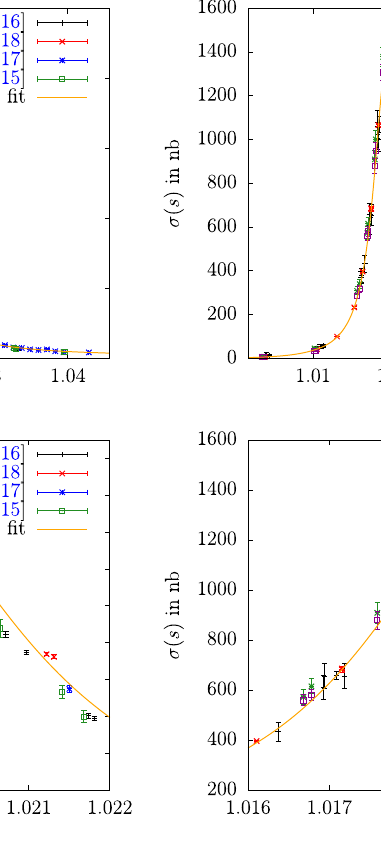
Fig. 5 Cross-section data as well as our combined fit to all data sets using the “combined c ” and “combined n ” residues for e + e − → K + K − (left) and e + e − → K S K L (right), respectively. Both are shown in the